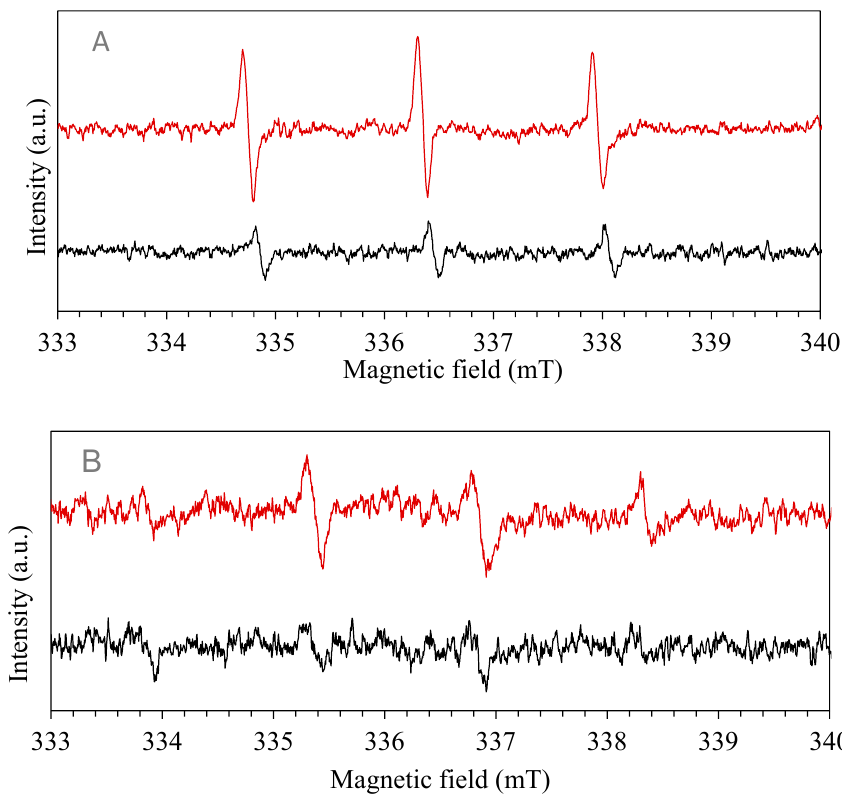
Figure 9. Electron paramagnetic resonance (EPR) spectra using as spin-trap: ( A ) TEMP, red for 5 min, black for 30 min; ( B ) DMPO, red for 5 min, black for 30 min.